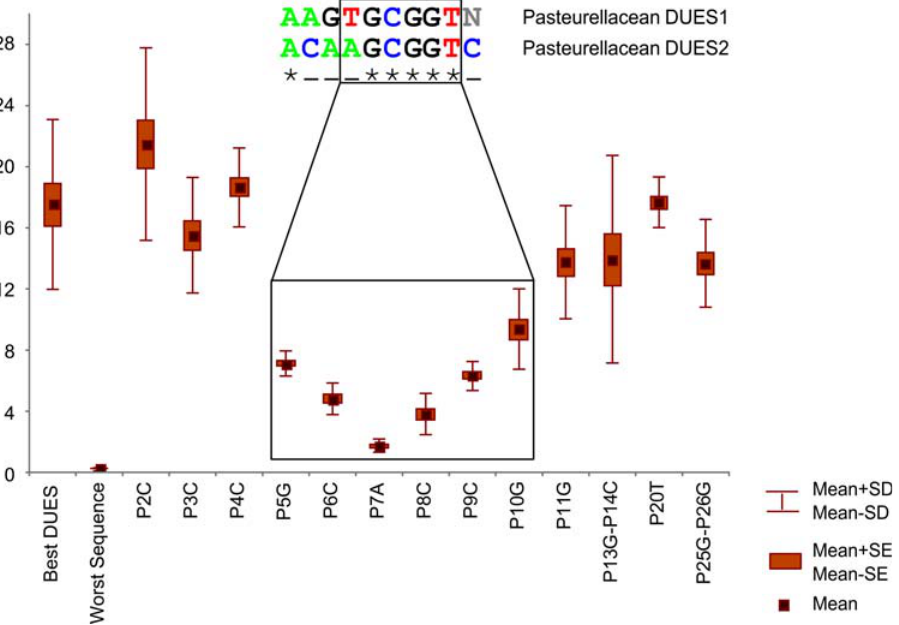
Figure 4. Relative uptake efficiency of H.influenzaeDUES and some of its mismatched forms. X-axis: Sequence tested. Best DUES: H. influenzae best DUES consensus. Worst Sequence: The 29 bp sequence of the least frequent nucleotides. PxN: Best DUES mutated at position x (Px) towards the least frequent nucleotide (N). Y-axis: Percentage of DNA taken up. SD: Standard deviation of the mean, SE: Standard error. Note that the critical part of the DUES largely coincides with the evolutionarily conserved positions of the two pasteurellacean DUESs currently